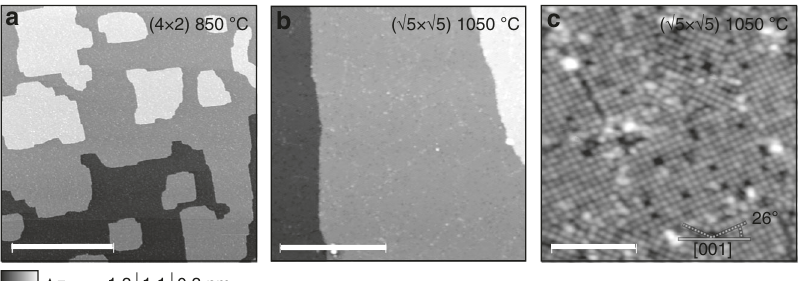
Fig. 1 STM topography of the STO surface. Overview of the c(4 × 2) reconstructed SrTiO 3 (100) surface after long-term annealing at T = 850 °C ( a ) and ffiffiffi p ffiffiffi p (cid:3) (cid:4) ´ (cid:2) R 26 ; 6 (cid:3) 5 5 reconstructed SrTiO 3 (100) obtained after annealing to T = 1050 °C (( b , c )) 41,42 . Images are constant current topographies with tunneling parameters U tip = 2 V, I = 30 pA ( a ) and U tip = − 1 V, I = 10 pA ( b , c ). Dark features visible after high-temperature annealing ( c ) are related to oxygen vacancies 42,46 . The length of the scale bar is 200 nm, 50 nm and 10 nm for a – c images,